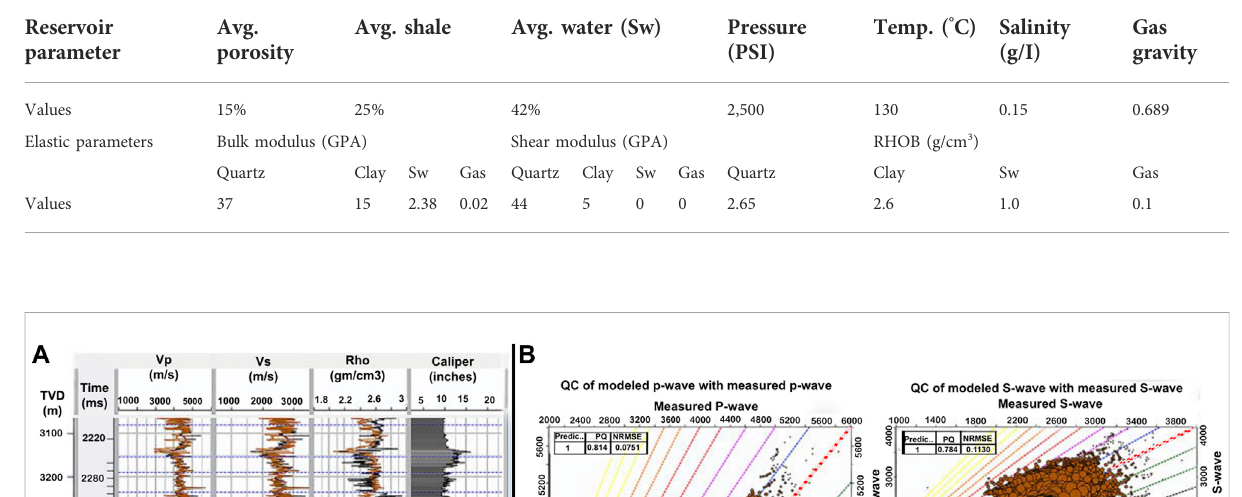
TABLE 2 Petrophysical and elastic properties of the reservoir utilized in PEMs.